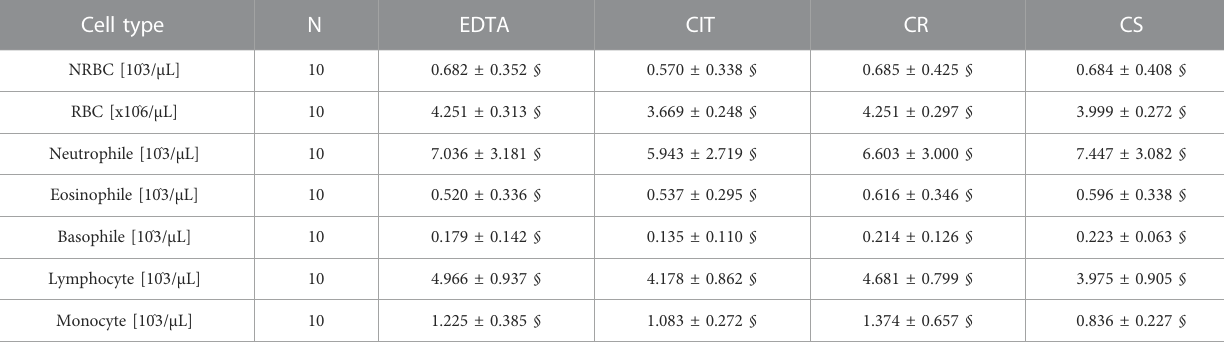
TABLE 5 Cell count [10 3 /µL] for each cell group and tube. Exclusively for RBC, the count is multiplied by 10 6 /µL. The data are reported as media ±